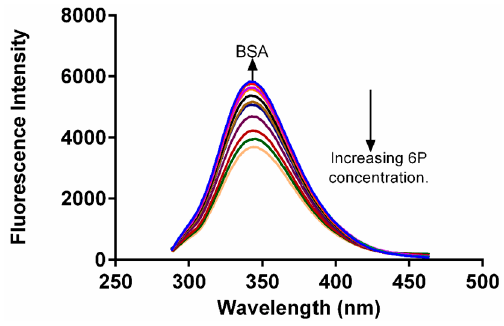
Figure 3. Spectra for fluorescence quenching of BSA in the presence and absence of 6P at 25 °C.